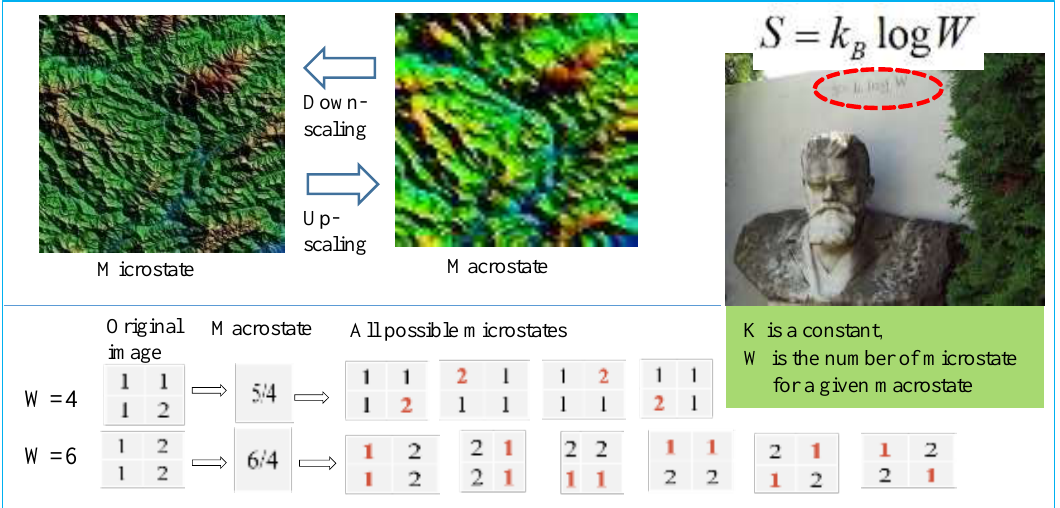
Fig.5 Definitions of macrostate and microstate for Boltzmann entropy (modified from Gao et al